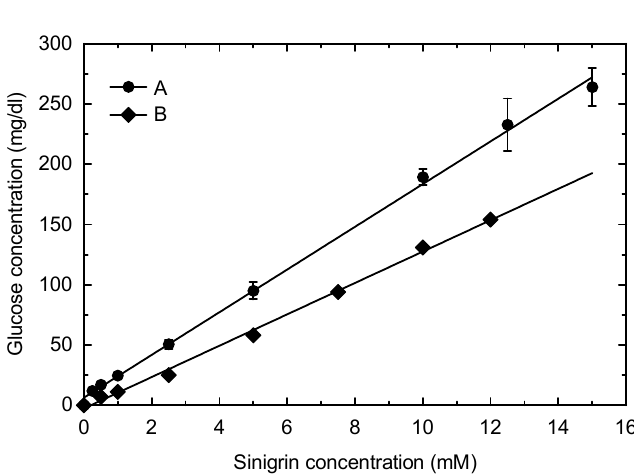
Fig. 4: Calibration curves prepared with sinigrin as standard. A – Calibration curve prepared with sinigrin dissolved in extract (y = 12.7 x; r 2 = 0.99). This fact takes the “matrix effect” into account. The glucose concentration originating from the extract is eliminated by subtraction. B – Calibration curve prepared with aqueous sini- grin solutions (y = 18.3 x; r 2 = 0.99).